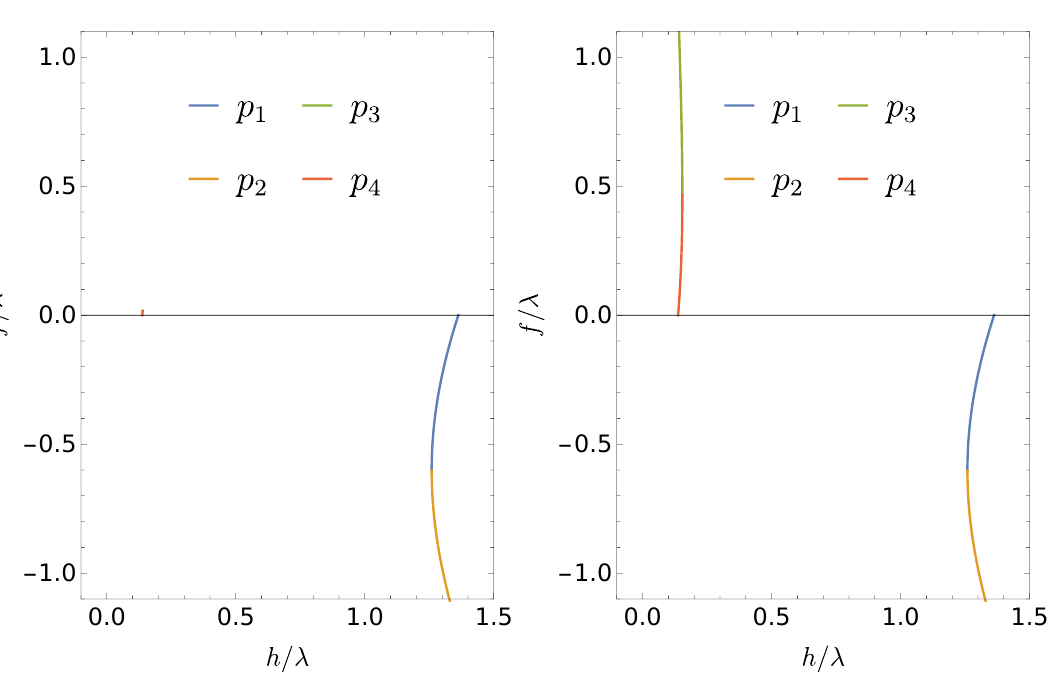
Figure 6 . Values of the couplings at the (cid:12)xed points p 1 = [ (cid:21) ? ; h ? for N s = 2 and N c = 28 (cid:12)xed. As we increase the number of fermions, the absolute values of the couplings at the (cid:12)xed decrease rather fast. We of course expect that this behaviour remains in the exact case.